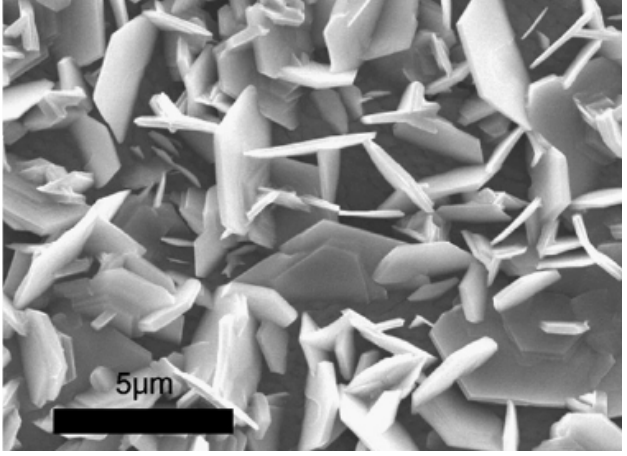
Figure 16. SEM images of ZnO nanodisks grown at 1000 °C in flowing Ar (99 sccm)/O (1 sccm) and then subjected to furnace cooling. Reprinted from Ref. [59] with